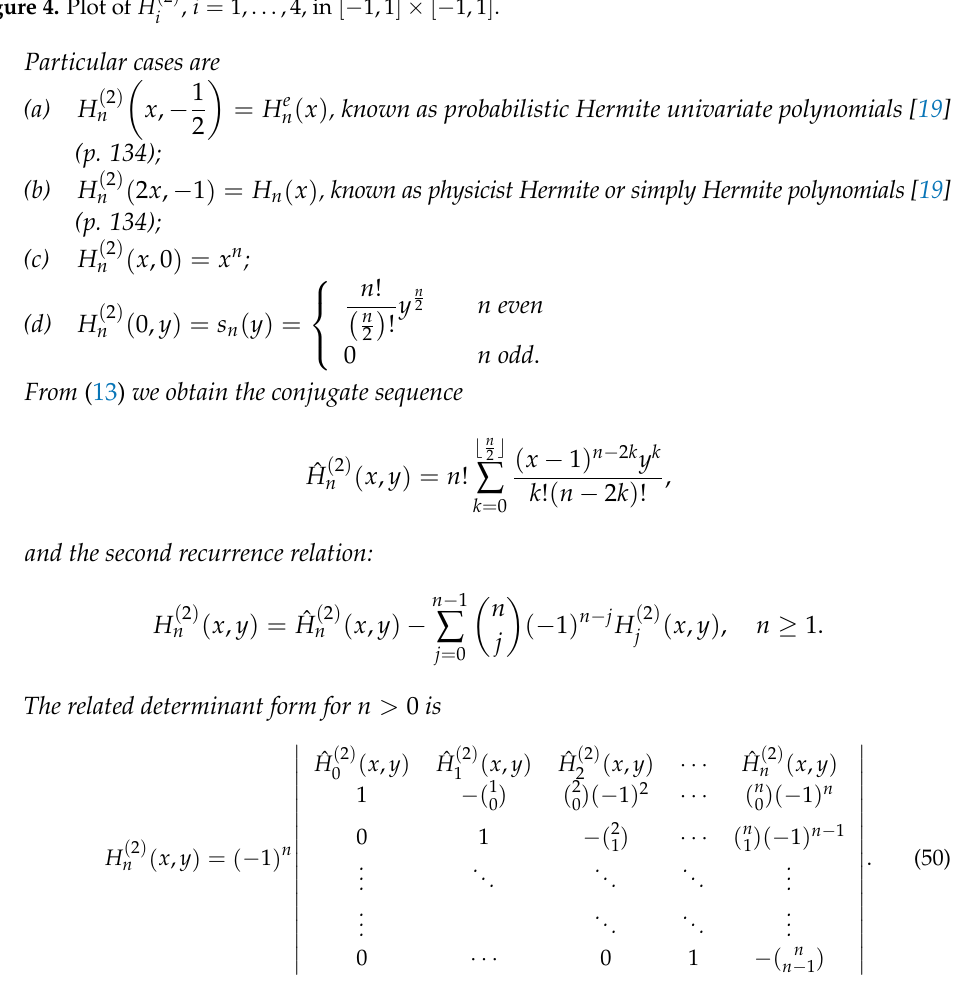
( 2 ) , i = 1, . . . ,4, in [ − 1,1 ] × [ − 1,1 ] i